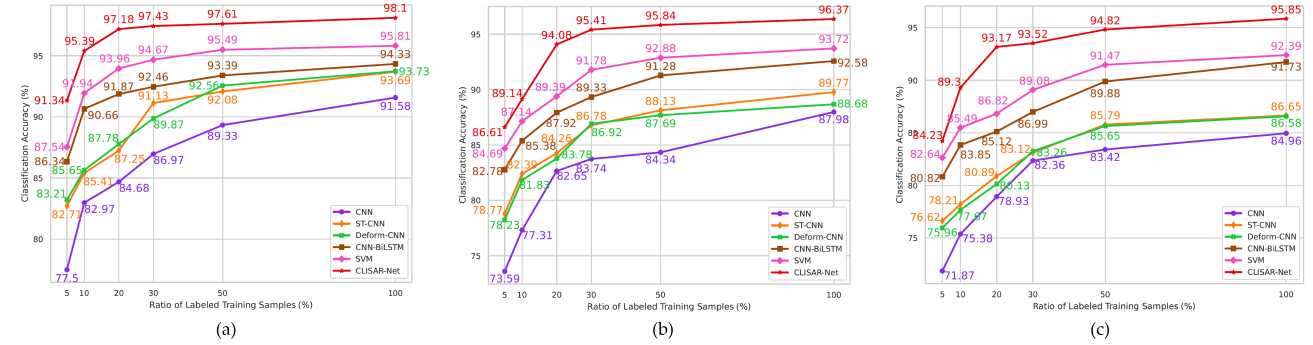
Figure 11. Comparison of the classification accuracy with different ratios of labeled training samples for different methods. ( a ) Results of scaled dataset, ( b ) results of rotated dataset, and ( c ) results of combined dataset.